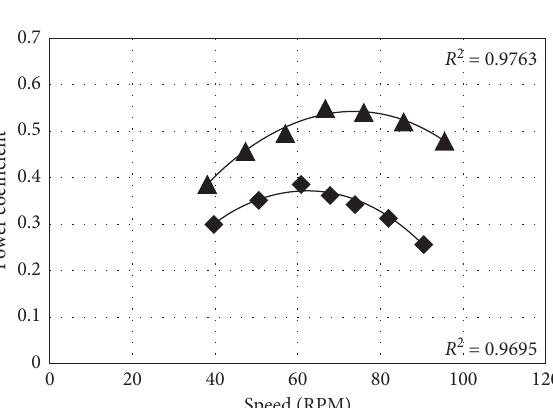
Figure 36: Runner 19 data